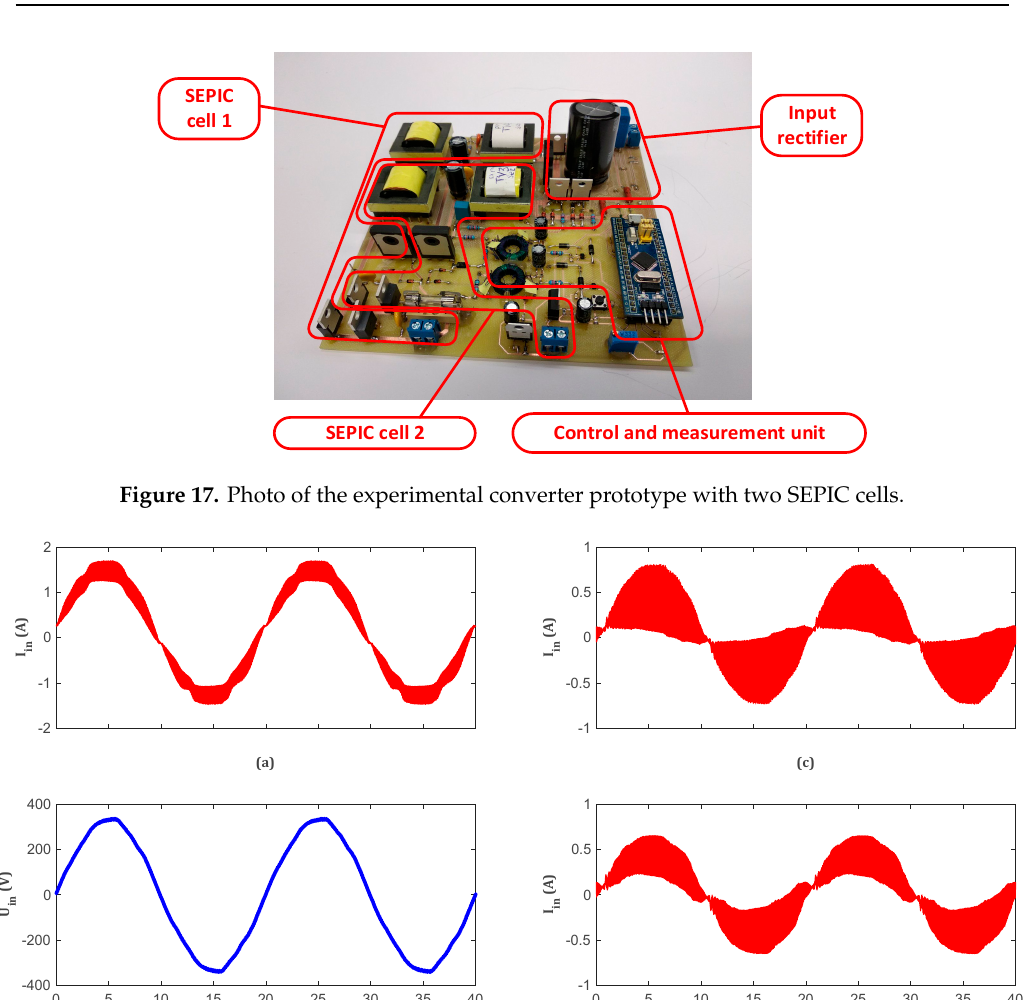
Energies 2019 , 12 , x FOR PEER REVIEW